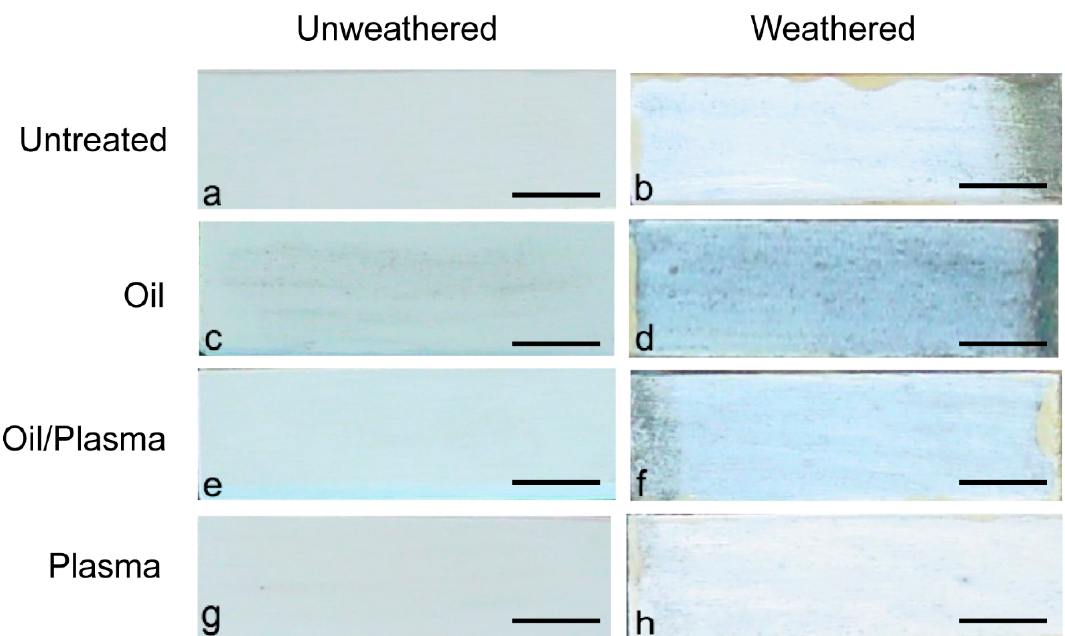
Figure 4 . Effects of hot-oil treatment and/or plasma modification on the appearance of an acrylic paint on blue-stained lodgepole pine samples exposed to 18 months of natural weathering (samples b,d,f,h). Unweathered controls on left-hand side (samples a,c,e,g) were stored in a conditioning room for 18 months. Scale bars = 11 mm.